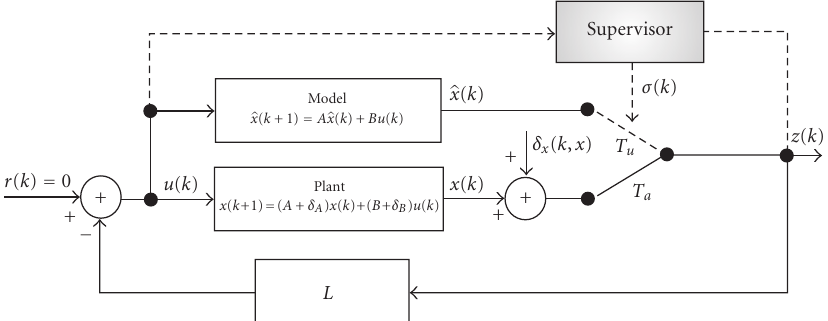
Figure 3: Block diagram of a discrete feedback system with linear actuator, and interrupted observations supervisor.